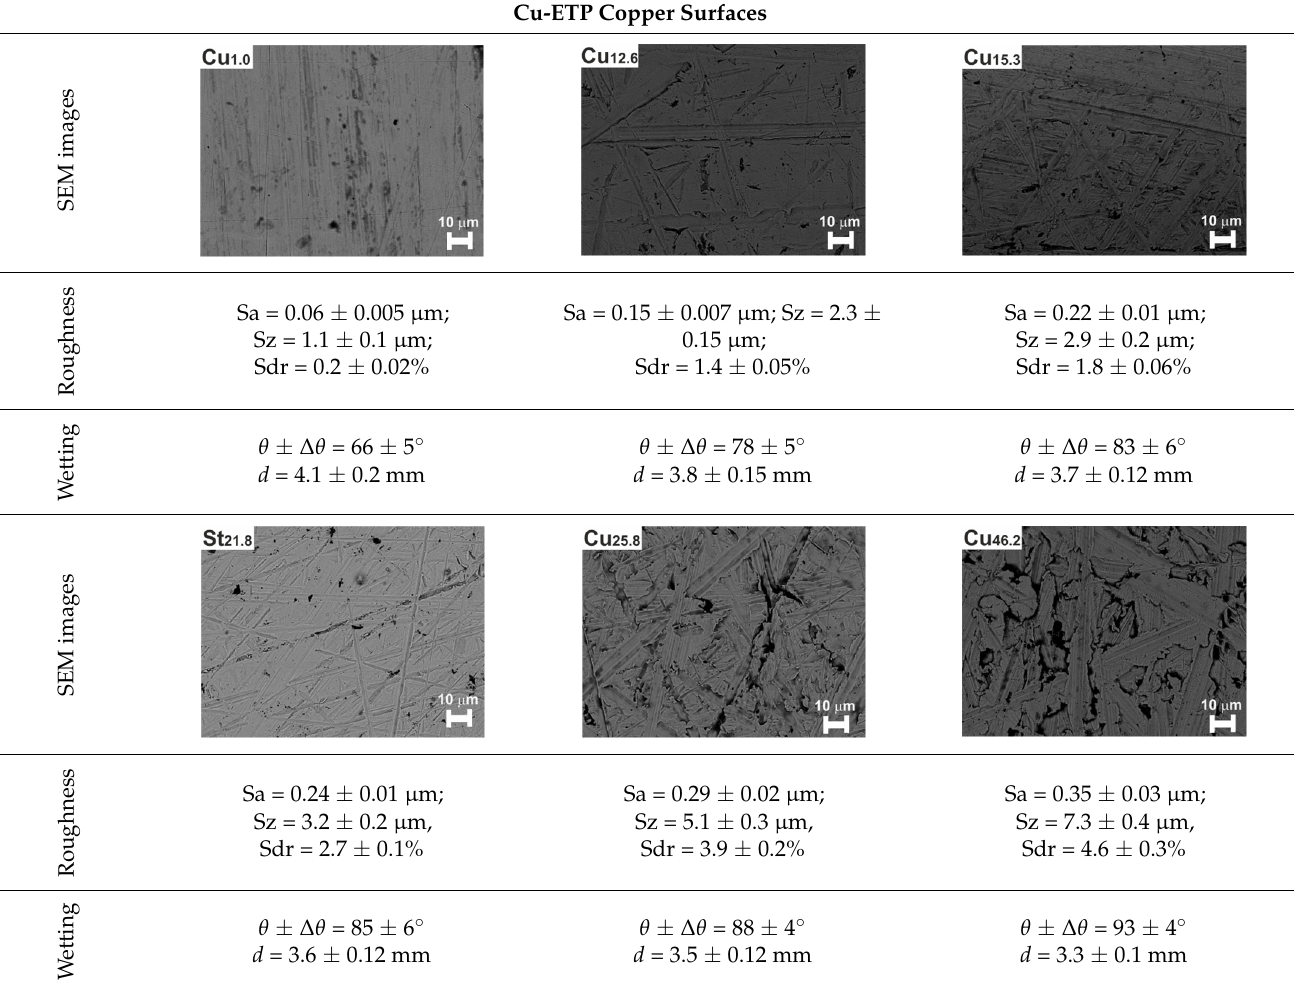
Table 2. SEM images and parameters characterizing roughness and wetting of steel surfaces.